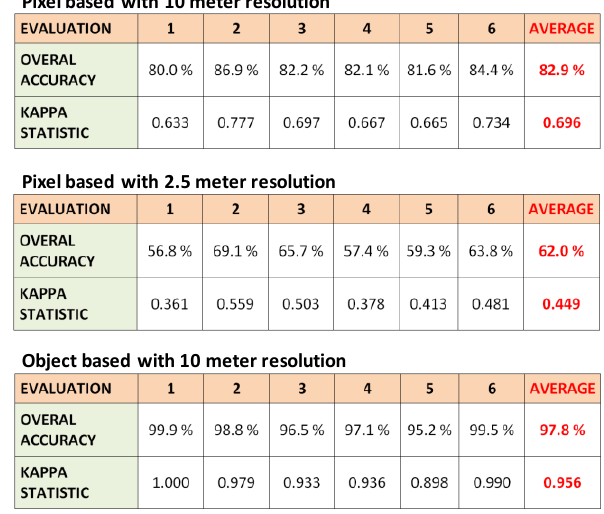
Figure 10. Accuracy evaluations for all classification